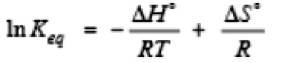
Figure 8. Modified Stern-Volmer plots of log [(F 0 –F)/F] versus log[drug] for nandrolone-ionic liquid-HSA system at different temper- atures; the presence of [BMIM]BF4 or [BMIM]PF6, [HSA] = 2 μM.